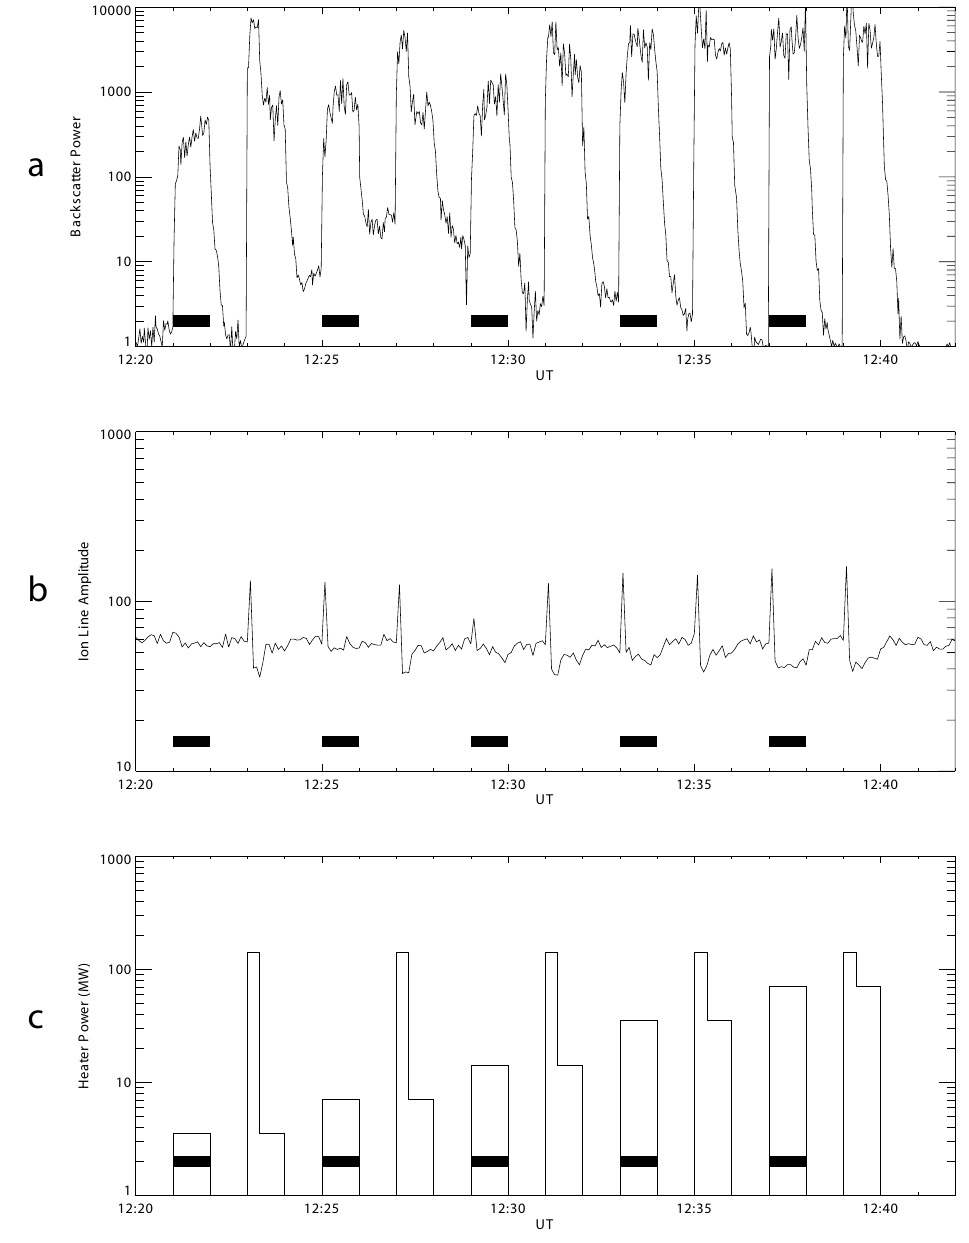
Fig 19 Fig. 19. Amplitudes of CUTLASS Finland backscatter (panel a ) and the unshifted centre frequency of the EISCAT UHF (Tromsø) ion-